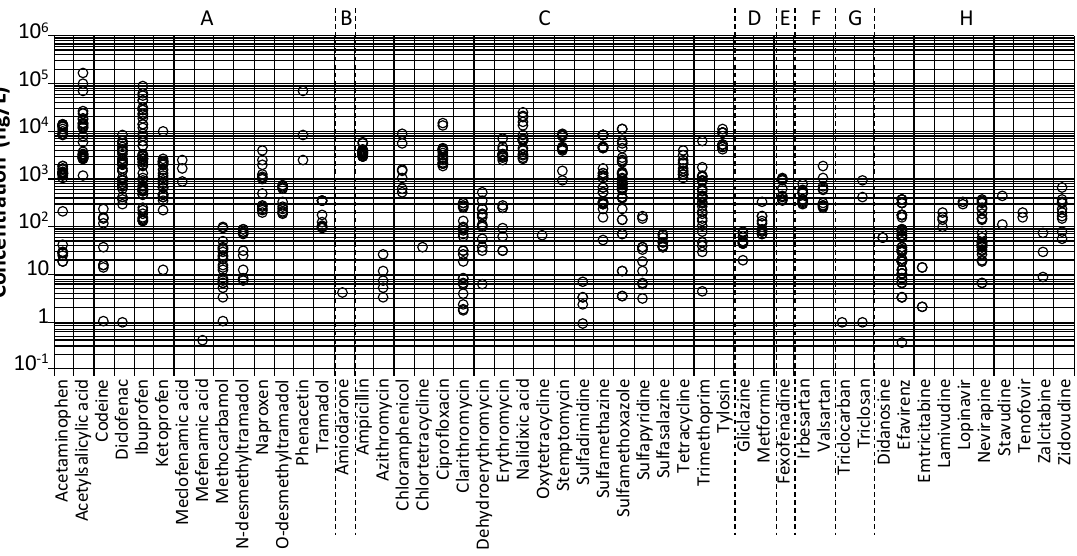
Figure 8. Observed concentrations of micropollutants belonging to classes ( A ) (Analgesics and anti-inflammatories), ( B ) (Antiarrhythmic agents), ( C ) (Antibiotics), ( D ) (Antidiabetic), ( E ) (Antihistamines), ( F ) (Antihypertensives), ( G ) (Antiseptics), and ( H ) (Antivirals) in surface water in the reviewed studies